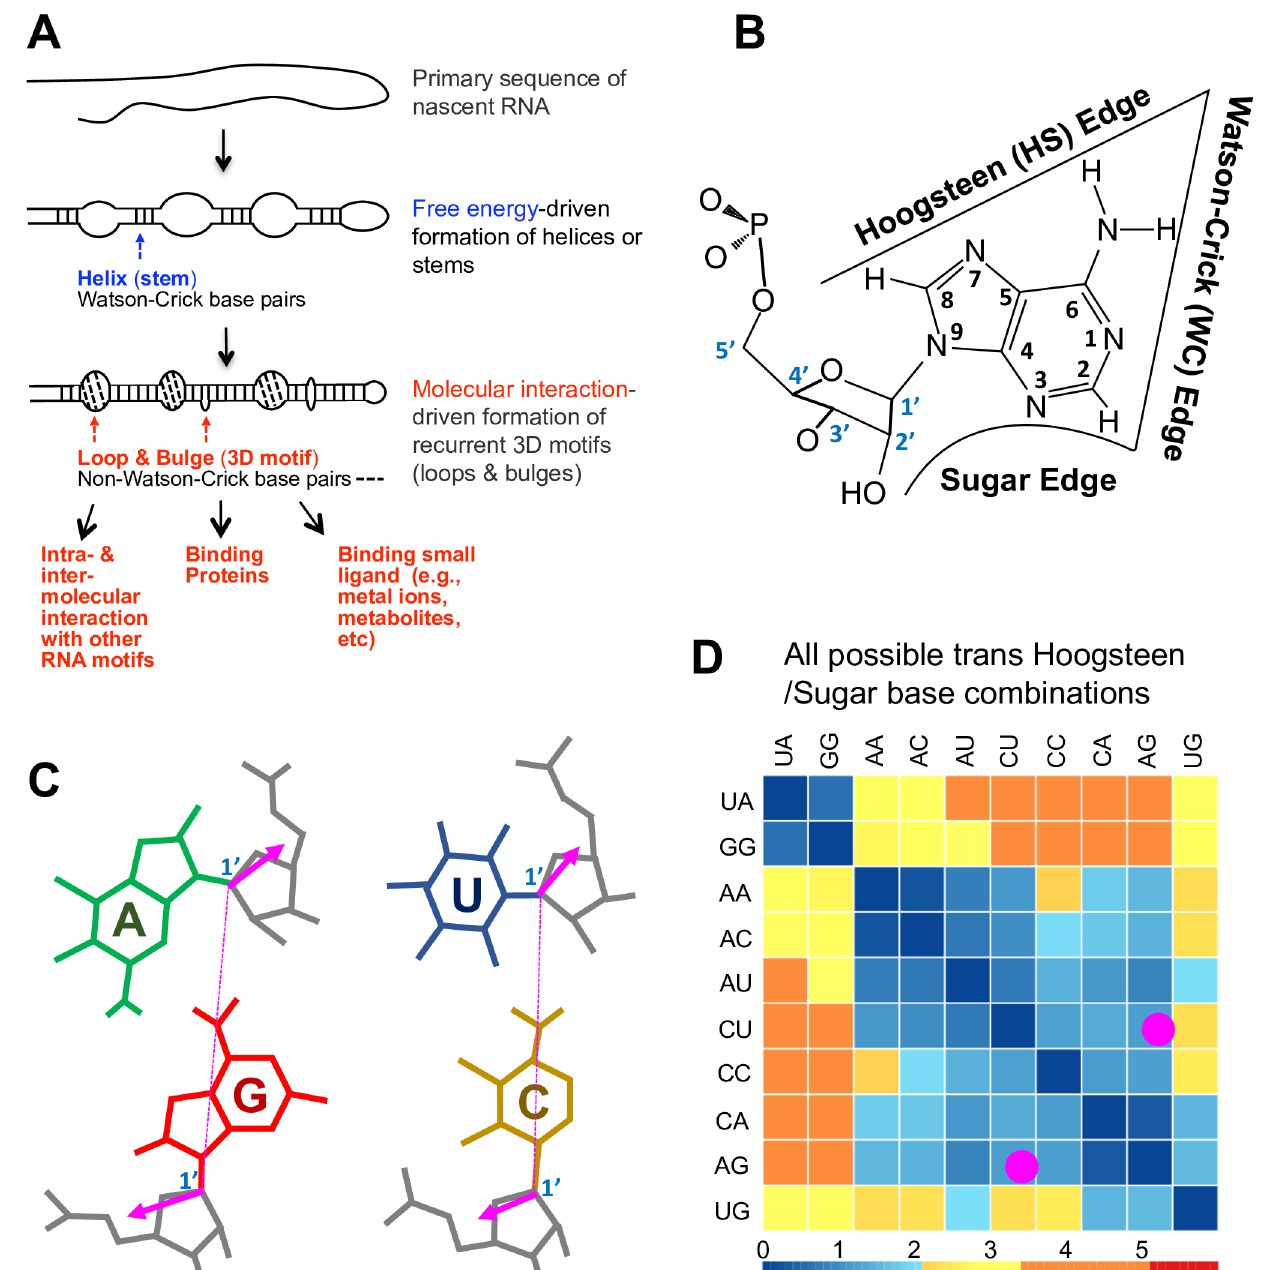
Fig 1. RNA structure basis. (A) Simple illustration of RNA primary, 2D, and 3D structures. (B) Three edges of adenine nucleotides. (C) Isosteric AG tHS and CU tHS base pairs. Glycosidic bond orientations are highlighted with magenta arrows. C1’-C1’ distances are highlighted with dashed magenta lines. (D) tHS IsoDiscrepancy Index heat map from the RNA Basepair Catalog. Any base combinations in the tHS family are listed, and AG vs CU is marked in magenta dot. Lower numeric value (less than 2.2 in blue color) dictates isosteric base pairs. Values between 2.2 and 3.5, colored in yellow, show nearly isosteric base pairs. Values above 3.5, colored in orange or red, dictate the nonisosteric base pairs. A, adenine nucleotides; C, cytocine nucleotides; G, guanine nucleotides; tHS, Trans Hoogsteen/Sugar edge; U, uridine nucleotides.